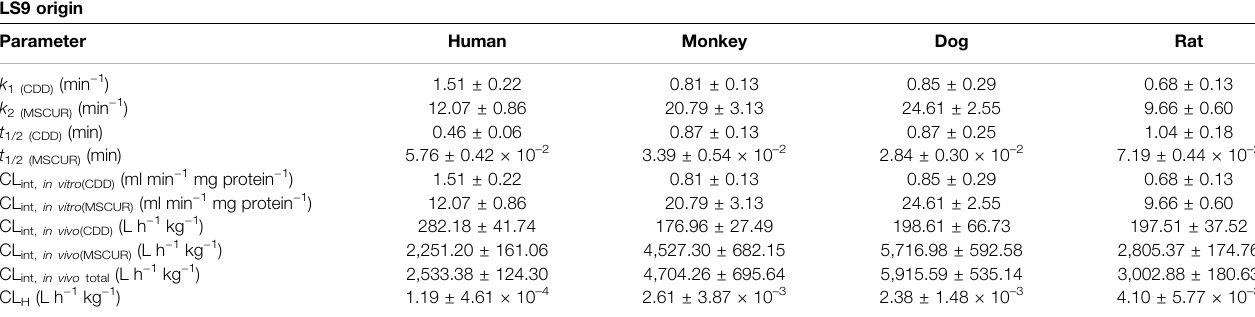
TABLE 2 | Kinetic parameters of hepatic hydrolysis of CDD and MSCUR in human, monkey, dog, and rat LS9. LS9 origin Parameter Human Monkey Dog